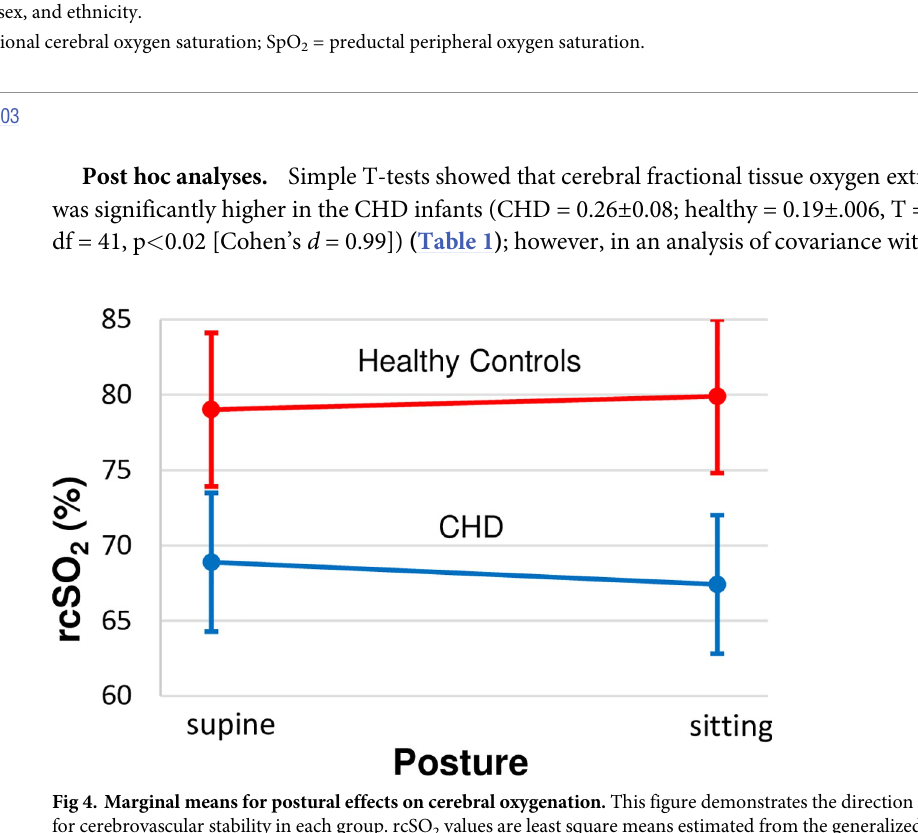
CHD = congenital heart disease; rcSO 2 = regional cerebral oxygen saturation; SpO 2 = preductal peripheral oxygen saturation. � p < 0.05.